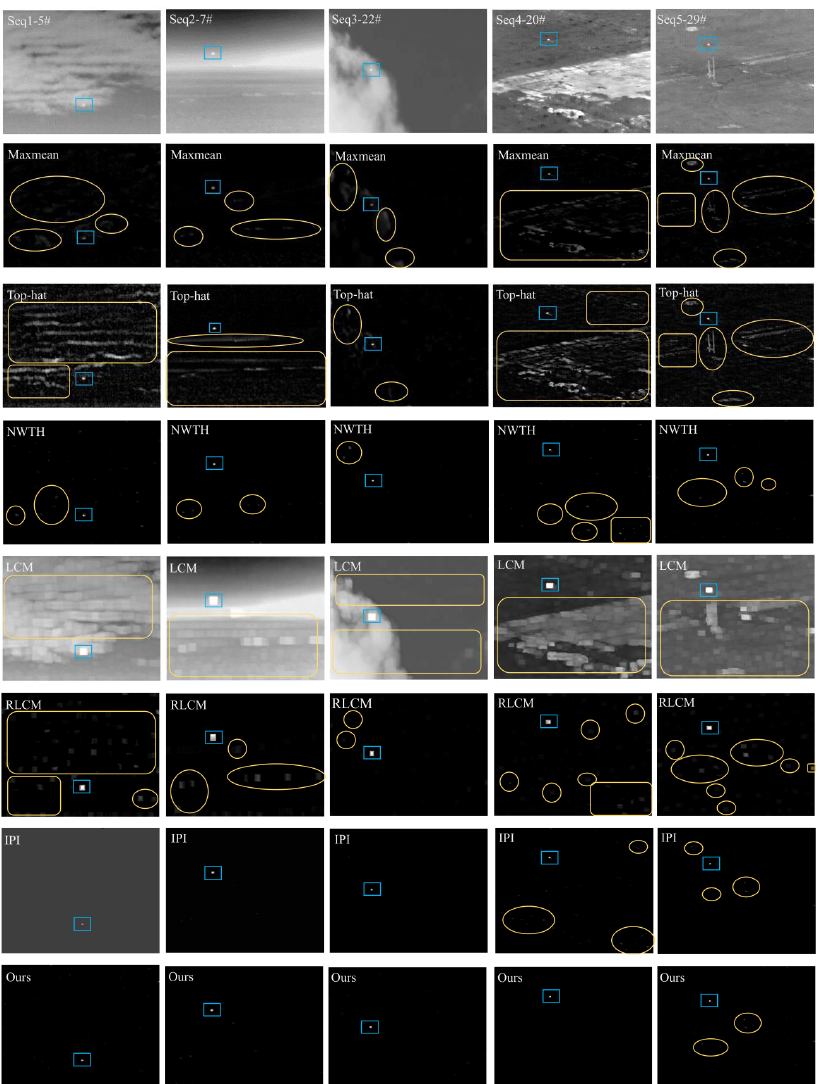
Figure 9. Background suppression results of the six methods (Table 2). # indicates the frame number. The blue rectangle represents the target, while the yellow box shows the false alarm point or the unsuppressed background.